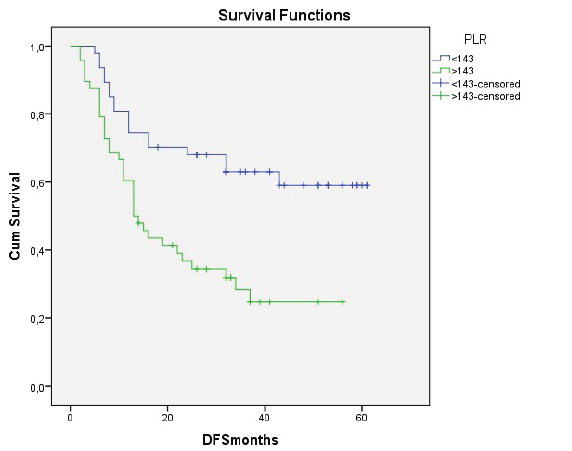
Figure 2a - Kaplan-Meier curve for overall survival of low and high platelet / lymphocyte group